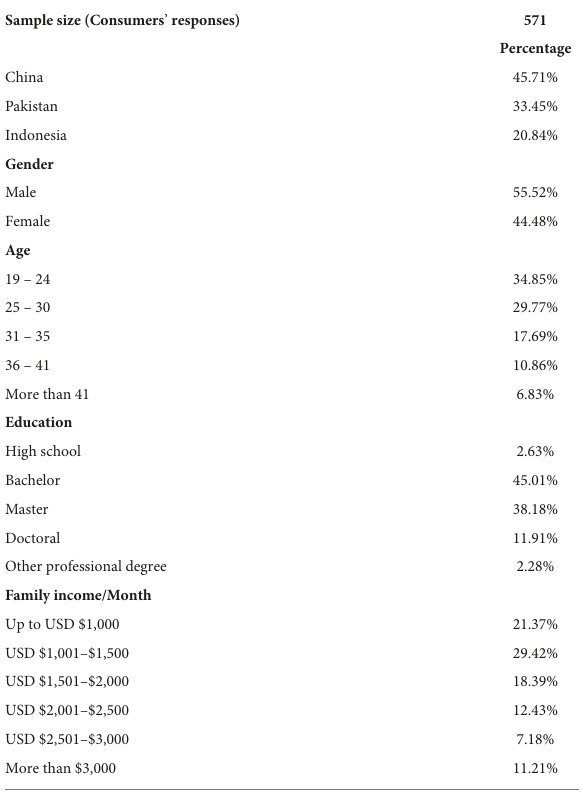
TABLE 1 Consumers’ demographic information.